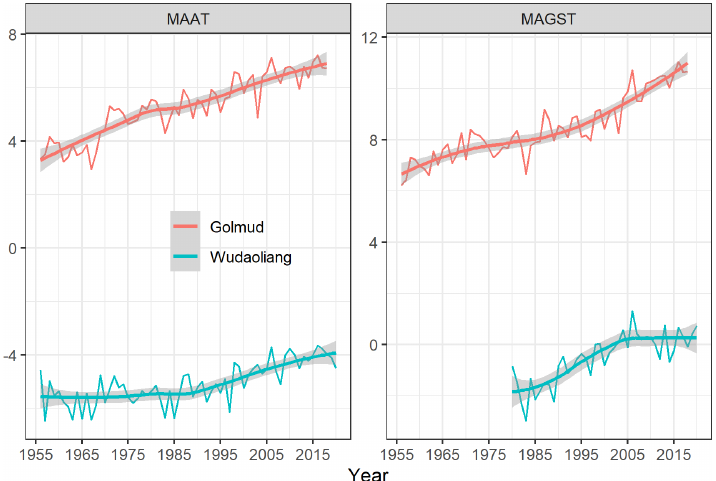
Figure H1. Mean annual air temperature (MAAT, ◦ ) and mean annual ground surface temperature (MAGST, ◦ ) at the meteorological stations Golmud and